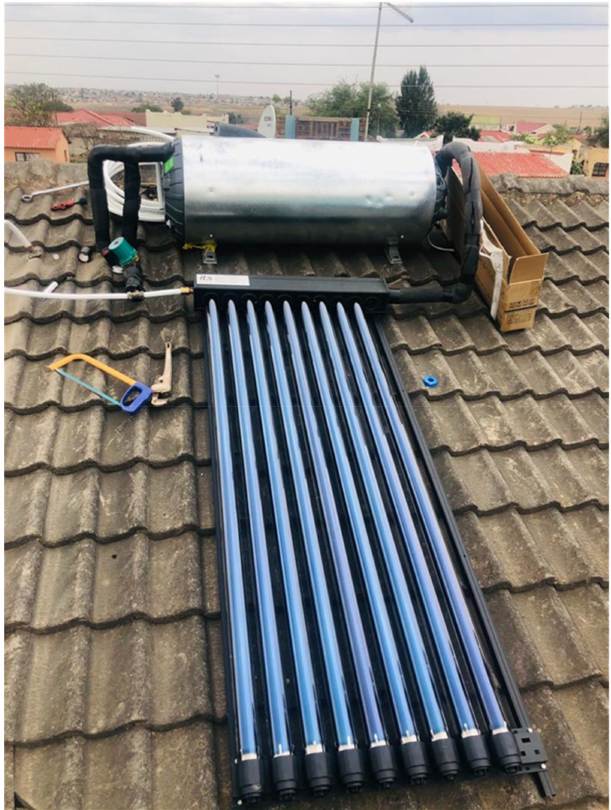
Figure 3. The installation of the SWH in the experimental residence in